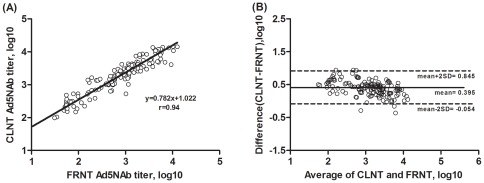
Comparison between CLNT and FRNT measurements.(A) Correlation between 50% Ad5 neutralizing antibody titers (log10) of 144 human sera positive by CLNT and FRNT assays. The line represents the fitted regression line. (B) Bland-Altman plot of Ad5NAb measurements using the CLNT and FRNT assays. Solid line indicates the mean value, and dashed lines represent 95% confidence limits. The x-axis indicates the average of Ad5NAb titers (log10) of CLNT and FRNT assays. The y-axis indicates the difference between the Ad5NAb titers (log10) of CLNT and FRNT assays.